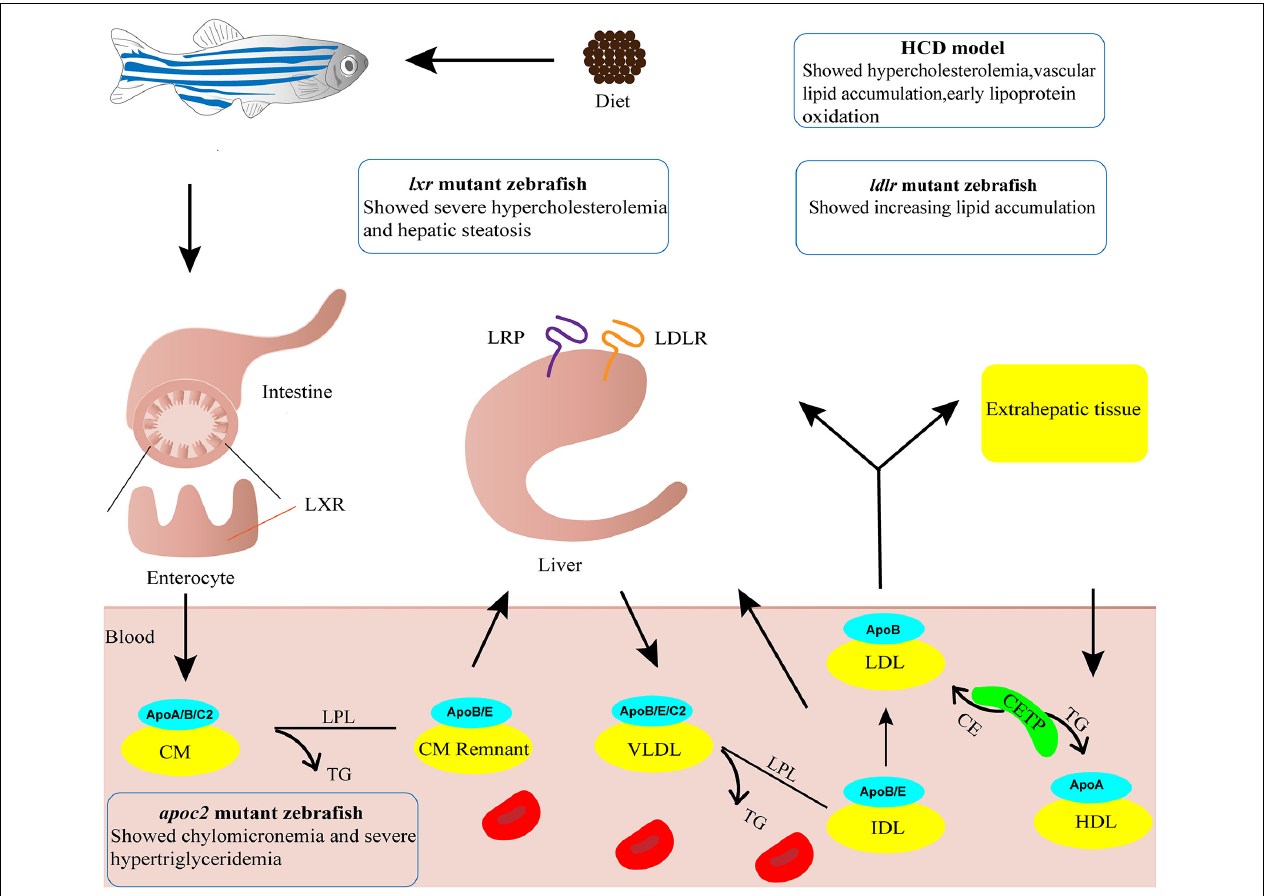
FIGURE 1 | Zebrafish models for atherosclerosis research. Cartoon shows lipid metabolism and transport of lipoproteins in zebrafish. The phenotypes of four zebrafish models used in atherosclerosis research are indicated. ApoA/B/C2/E, Apolipoprotein A/B/C2/E; CE, cholesteryl ester; CETP, cholesteryl ester transfer protein; CM, chylomicron; CM Remnant, chylomicron remnant; HCD, high cholesterol diet; HDL, high-density lipoprotein; IDL, intermediate-density lipoprotein; LDL, low-density lipoprotein; LDLR, low-density lipoprotein receptor; LPL, lipoprotein lipase; LRP, low density lipoprotein receptor-related protein; LXR, liver x receptor; TG, triglyceride; VLDL, very-low-density